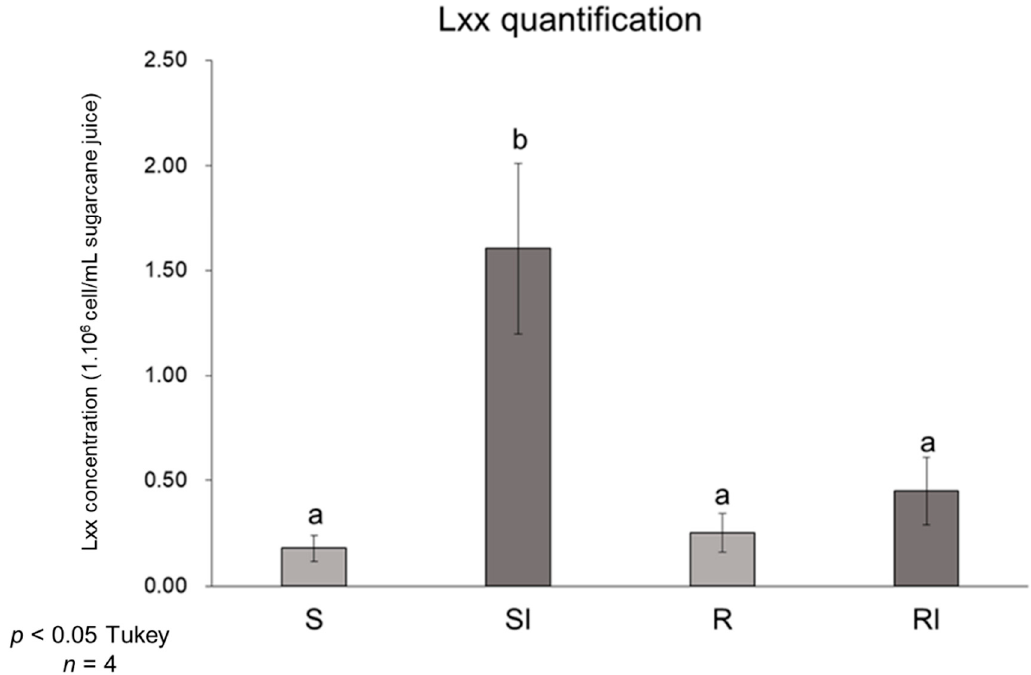
Figure 1. Lxx concentration ( × 10 6 bacterial cells/mL of sugarcane extract) at 180 days after inoculation (DAI) in mock- inoculated or Lxx-inoculated plants of the susceptible (S and SI, respectively) and resistant (R and RI, respectively) varieties determined by qPCR. Letters indicate significantly different means according to Tukey’s test ( p < 0.05). Bars represent standard errors ( n = 4).